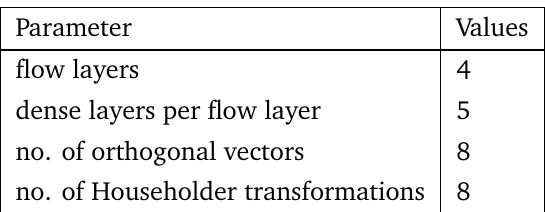
Table 11: SNF model hyper-parameters.